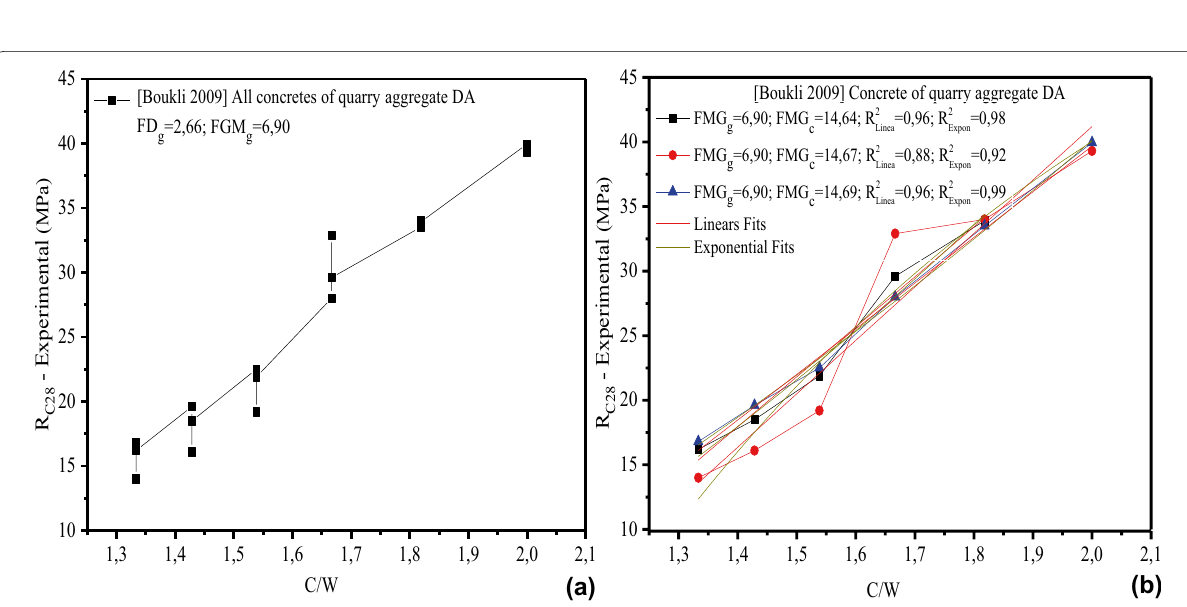
Fig. 12 Evolution of R C28 as a function of the ratio C / W the aggregate DA Boukli et al. (2009). a Results of all concretes FD g and FGM g , b results given by the models FGM g and FGM C